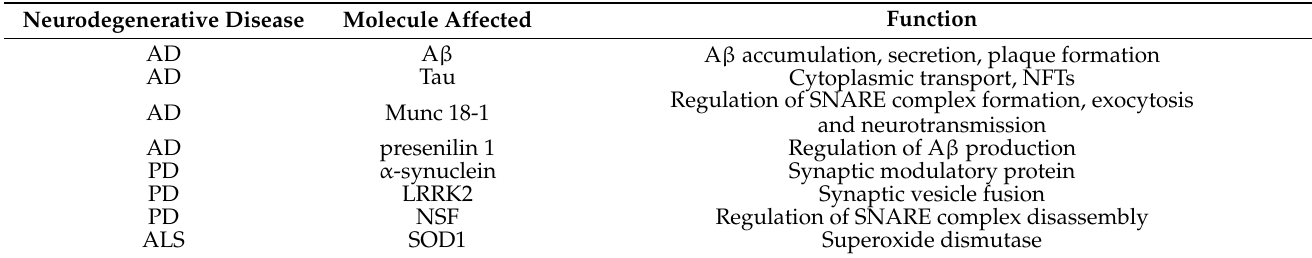
Table 2. Molecules affected by the SNARE proteins in the pathophysiology of neurodegenerative diseases. Neurodegenerative